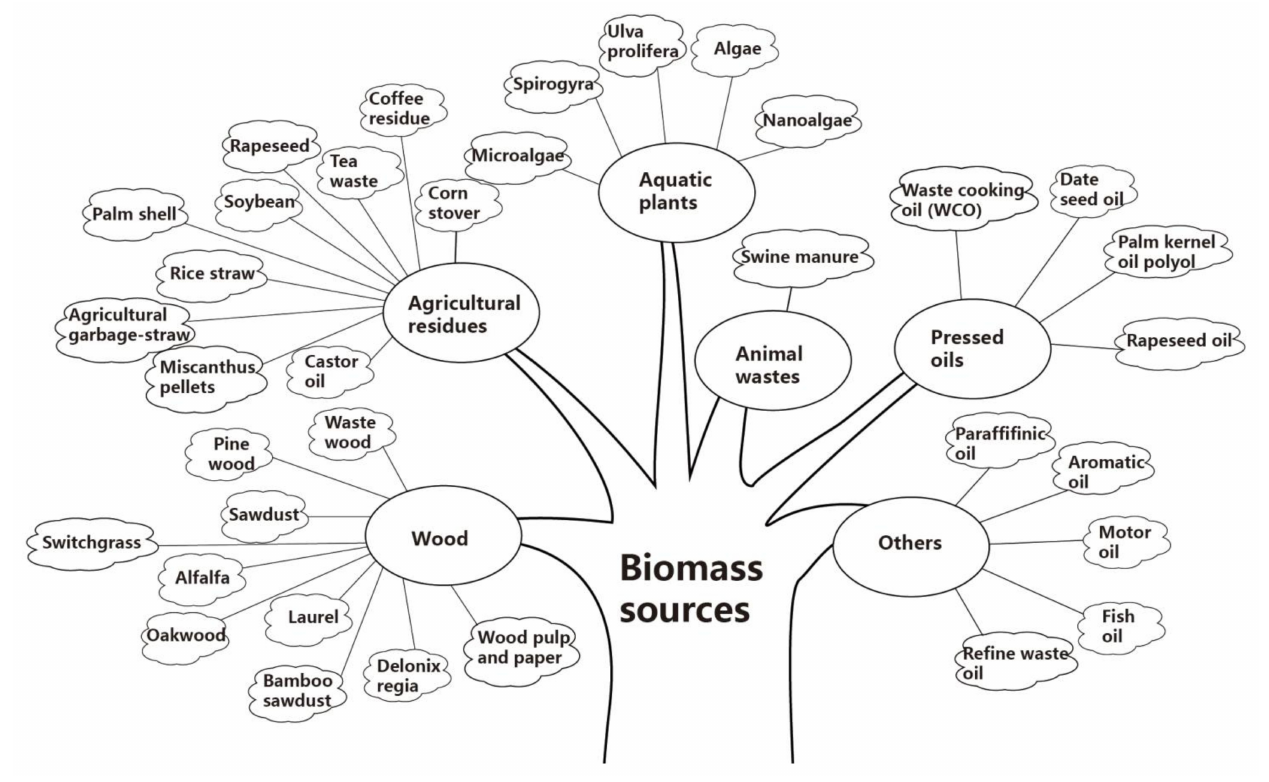
Figure 2. Various biomass sources involved in this review.